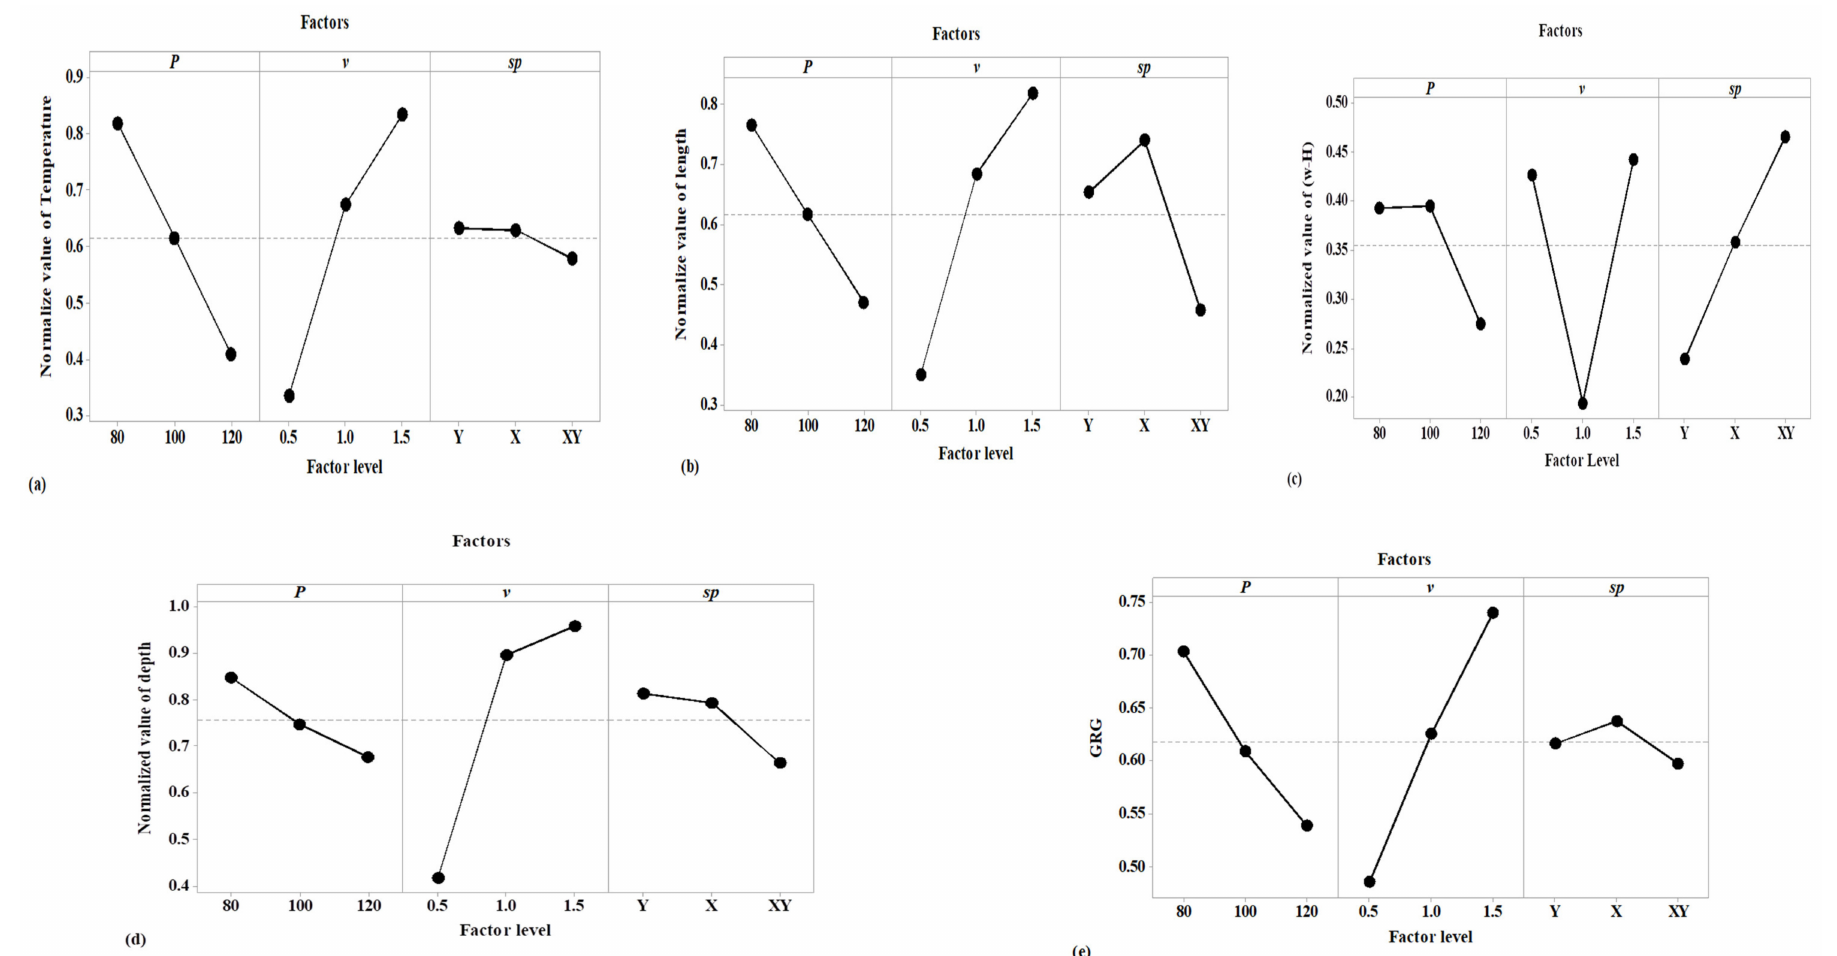
Figure 11. Main effect plot of normalized response of ( a ) Temperature ( b ) Length ( c ) w-H ( d ) depth and ( e ) Main effect plot of